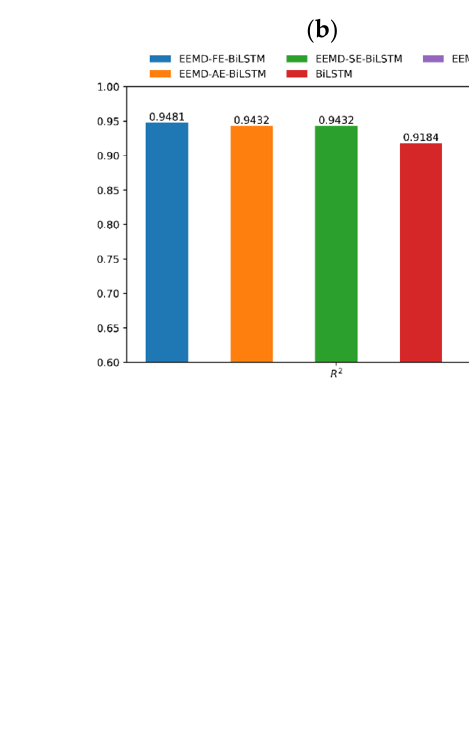
Figure 7. Comparison of horizontal errors of prediction models: ( a ) EMD decomposition; ( b ) EEMD decomposition; ( c ) CEEMDAN decomposition.